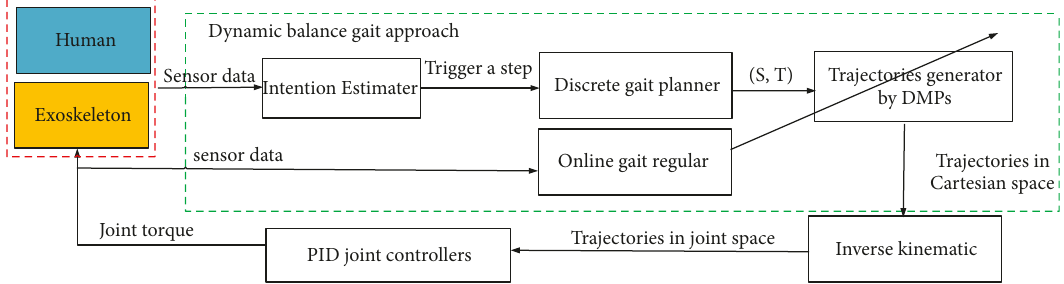
Figure 1: The framework of dynamic balance gait planning.